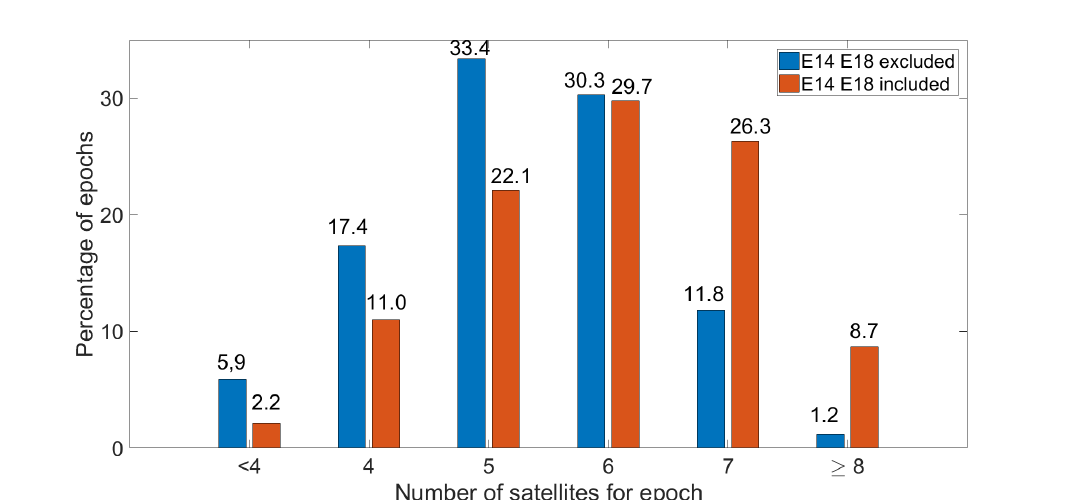
Figure 5. Percentage of epochs with the same satellite number. The height of each bin represents the percentage of epochs with the number of satellites indicated on the xaxis. Blue bars refer to the Galileo configuration without the Milena (E14) and Doresa (E18) satellites, while red bars refer to the Galileo constellation including the Milena (E14) and Doresa (E18)